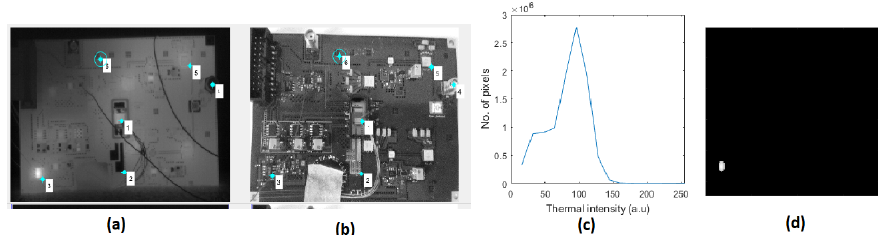
Figure 2. ( a ) Thermal profile of circuit board front ( b ) Obtained image with visible camera to understand the spatial position of different components, ( c ) Histogram of thermal profile, ( d ) Segmented high heat area.